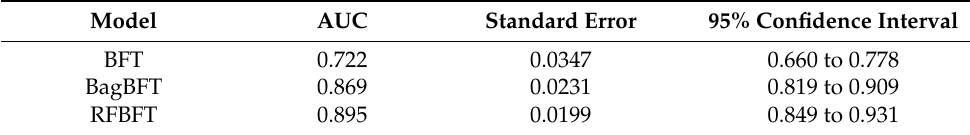
Figure 8. ROC curves of the models: ( a ) training dataset, ( b ) validation dataset. Table 3. Parameters of ROC curves with the training dataset.